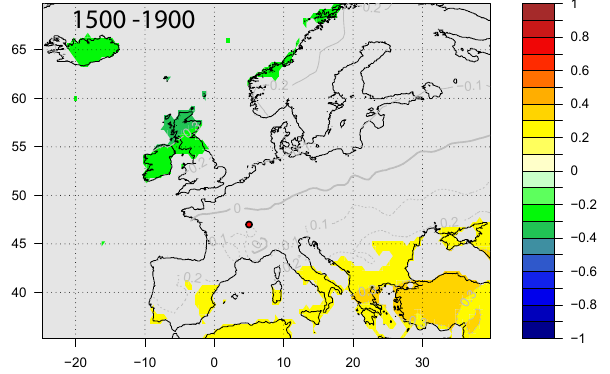
Fig. 5. Correlation of the GHD with the winter near-surface tem- perature from Luterbacher et al. (2004) for the period from 1500 to 1900. All data were low-pass filtered using a 1/10 year cutoff. Areas of significant correlation are coloured ( p < 0.05).